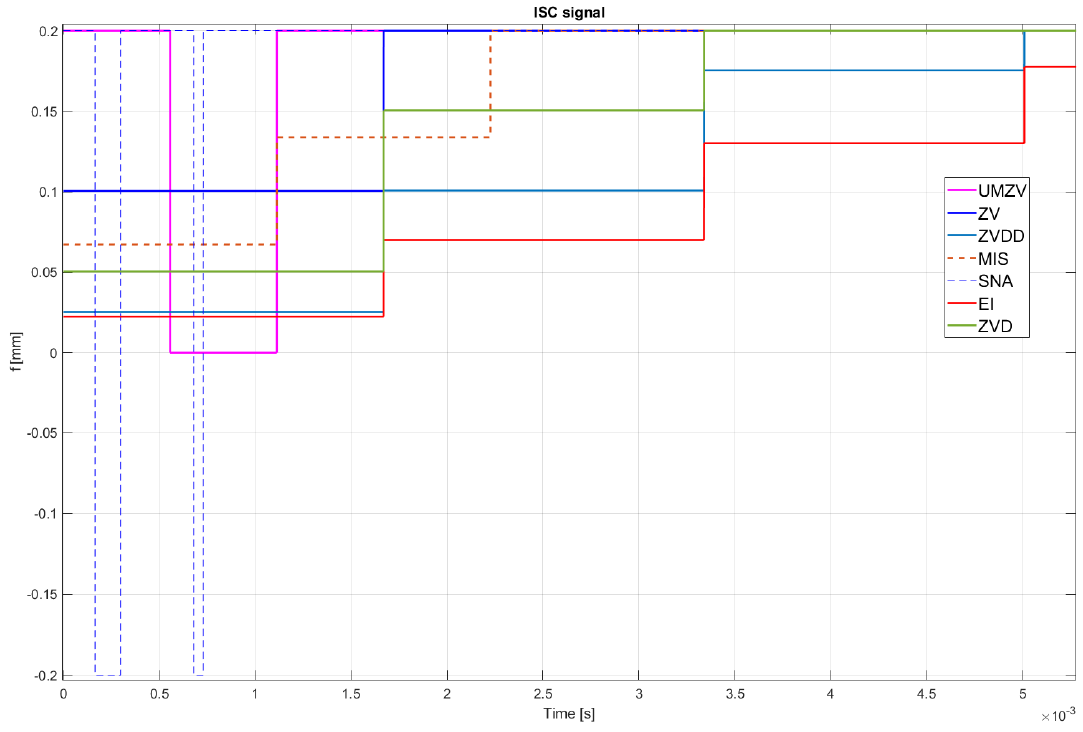
Figure 10. ISC signal of UMZV, ZV, ZVD, ZVDD, MIS, SNA and EI algorithm during finishing machining.